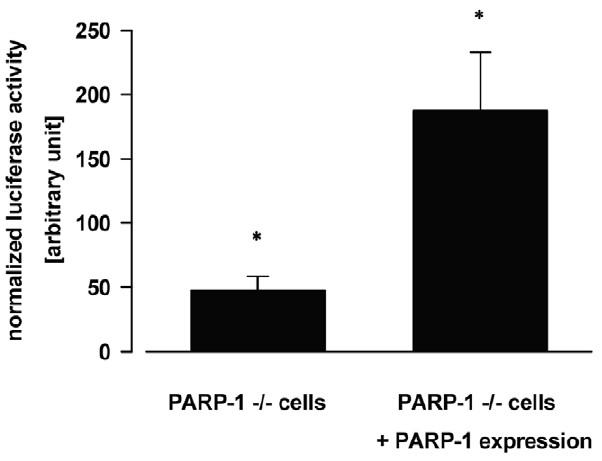
Figure 3. The expression of h PARP-1 in vivo increases the luciferase enzyme activities assayed in Del4 reporter plasmid transfected PARP 2 / 2 MEF cells. Logarithmically growing PARP 2 / 2 MEF cells were transfected with Del-4 plasmid together with the pcDNA3.1- beta-galactosidase expressing plasmid and in the absence or in the presence of h PARP-1 expression (pcDNA3.1- parp-1 plasmid).